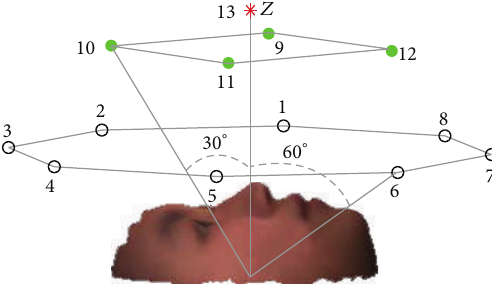
Figure 8: Positions of the 13 lamp-houses.